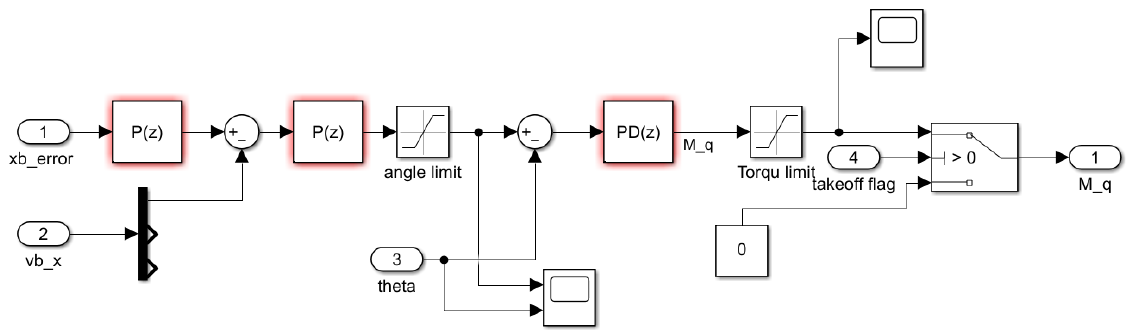
Figure 8. The PID controller controls X (current pitch). − The equations describing the vertical motion of the